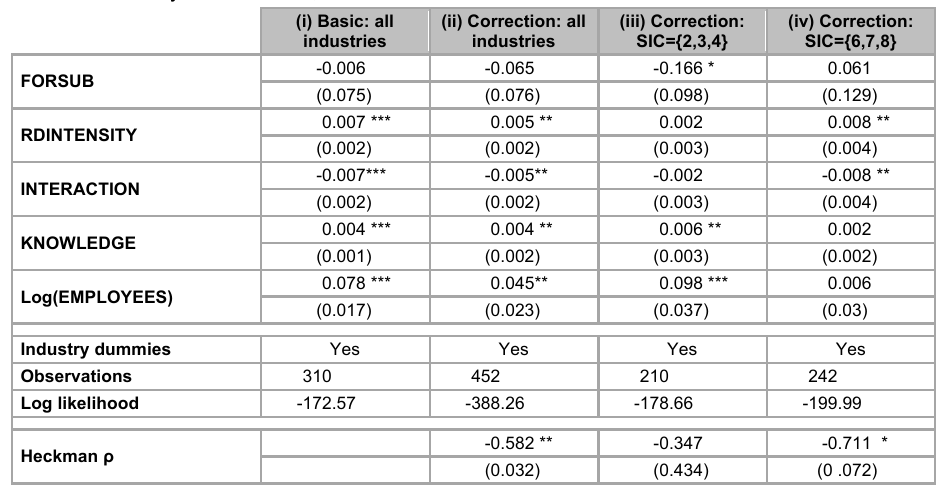
Regression results for multinational corporations and the type of innovations